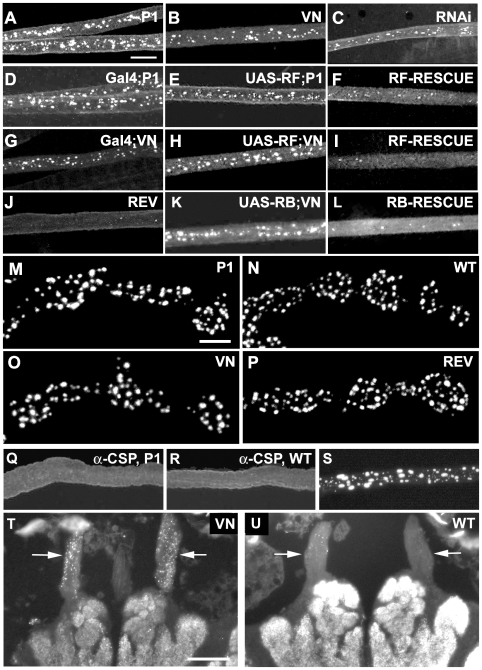
Mutation of the Srpk79D gene leads to the selective accumulation of the active zone protein BRP in axons of larval and adult nerves, but does not qualitatively change BRP distribution in synaptic boutons or neuropil.(A–I). Bruchpilot accumulations are observed in larval nerves of the hypomorph Srpk79DP1 (A), the null mutant Srpk79DVN (B), an elav-driven RNAi line elav-Gal4;;UAS-Srpk79D-RNAi (C), the parental lines for the P1-rescue with the PF isoform, w,elav-Gal4;;Srpk79DP1 (D) and w;UAS-cDNA-RF;Srpk79DP1 (E), the parental lines for the null-rescue with the PF isoform, w,elav-Gal4;;Srpk79DVN (G) and w;UAS-cDNA-RF;Srpk79DVN (H), and the parental lines for the null-rescue with the PB isoform (G) and w;UAS-cDNA-RB-eGFP;Srpk79DVN (K). The revertant Srpk79DREV (J) and wild type (w1118, not shown) lack these structures. In the P1-rescue line w,elav-Gal4;UAS-cDNA-RF;Srpk79DP1 (F) and the null-rescue lines w,elav-Gal4;UAS-cDNA-RF;Srpk79DVN (I) and w,elav-Gal4;UAS-cDNA-RB-eGFP;Srpk79DVN (L) the density of BRP accumulations is strongly reduced. (M–P). Typical chains of synaptic boutons type Ib stained with anti-BRP antibody nc82 on larval body wall muscles 6/7 of the hypomorphic mutant Srpk79DP1 (M), wild type w1118 (N), null mutant Srpk79DVN (O), and revertant Srpk79DREV (P). No difference in the distribution and qualitative expression levels of the presynaptic active zone protein BRP is seen between Srpk79D mutants and wild type. (Q–R). CSP does not accumulate in the larval nerves of the hypomorphic mutant Srpk79DP1 (Q) or the null mutant (not shown). (R) w1118 control. (S) Overexpression of BRP also leads to BRP accumulations in larval nerves. (T–U) BRP immunohistochemistry on frozen head sections of the null mutant Srpk79DVN (T) and wild type (U) reveals that massive spot-like BRP accumulations are observed in adult Srpk79DVN null-mutant antennal nerves (arrows in (T)). Larval preparations in (A–P) and (S) and the head sections in (T) and (U) were stained with monoclonal antibody (MAB) nc82 (anti-Bruchpilot). Larval nerves in (Q) and (R) were stained with MAB ab49 (anti-CSP). Scale bar in (A) for (A L), (Q–S): 10 µm. Scale bar in M for (M–P): 2 µm. Scale bar in (T) for (T–U): 50 µm.